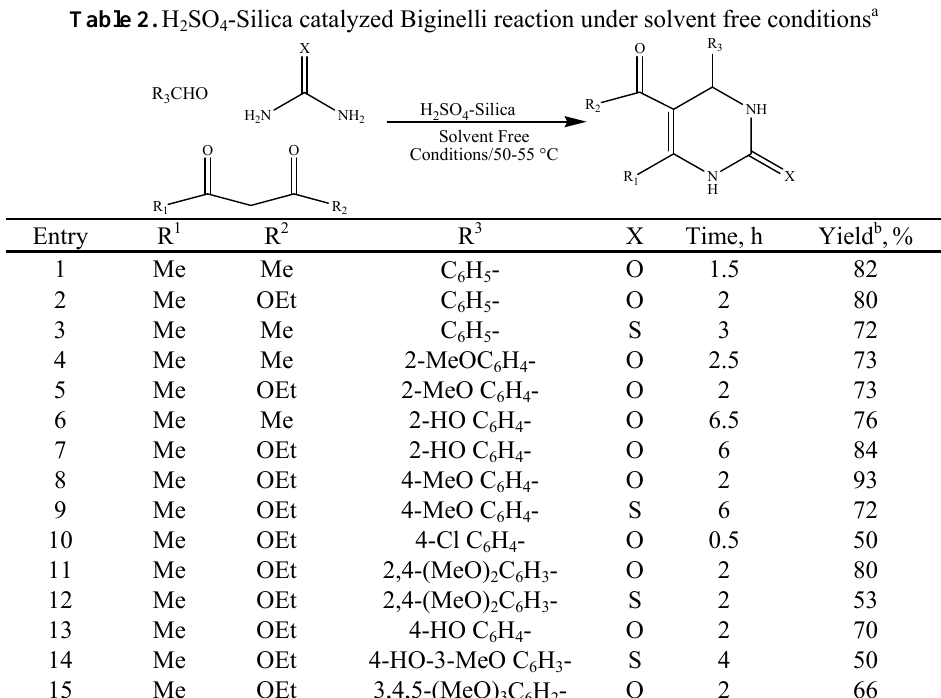
Table 2. H SO -Silica catalyzed Biginelli reaction under solvent free conditions a 2 4 X R 3 CHO H 2 N NH 2